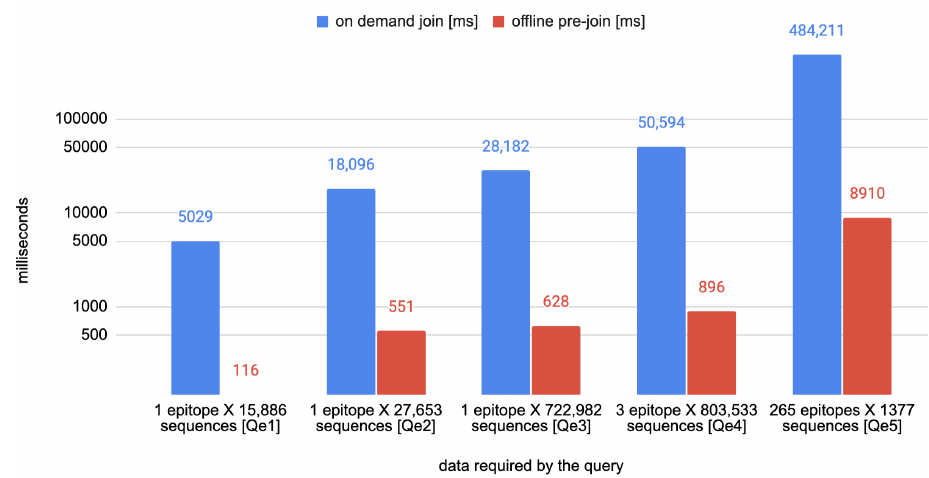
Figure 4. Comparison of the time needed for executing the queries Qe1–5 with and without the use of the optimized epitopes’ stability